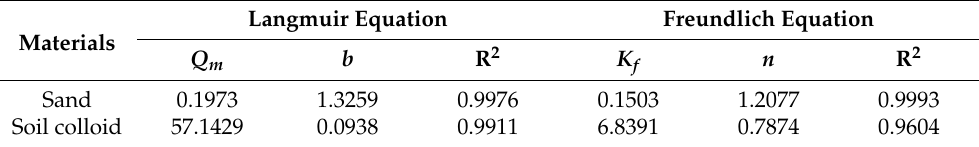
Figure 4. Langmuir model for Ni 2+ adsorption on ( a ) sand and ( b ) soil colloids; Freundlich model of Ni 2+ adsorption on ( c ) sand and ( d ) soil colloids. Table 2. Parameters of Langmuir and Freundlich models for Ni 2+